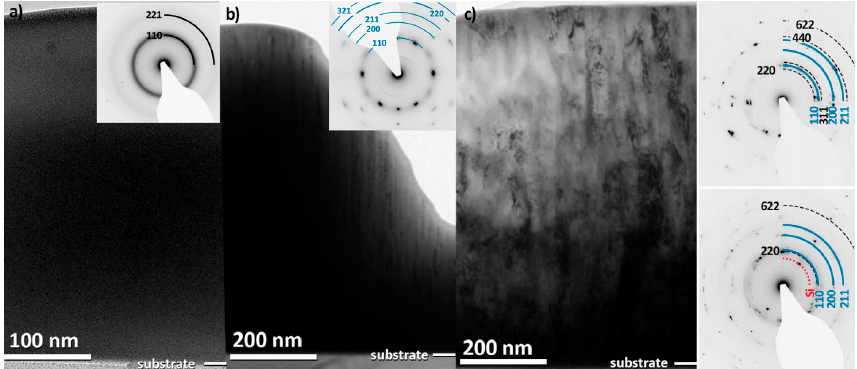
Figure 2. Transmission electron microscopy (TEM) cross-section of HfNbTiVZr films grown on Si substrates using a T sub of ( a ) RT, ( b ) 275 °C, and ( c ) 450 °C. The respective selective area electron diffraction (SAED) patterns are inserted in the images where blue solid rings indicate the bcc phase (in ( b ) and ( c )), and black dashed rings (in ( c )) indicate the C15 Laves phase. The SAEDs presented in ( c ) were recorded with a distance of 200 nm and 600 nm from the Si substrate. The dotted red ring corresponds to the Si substrate.